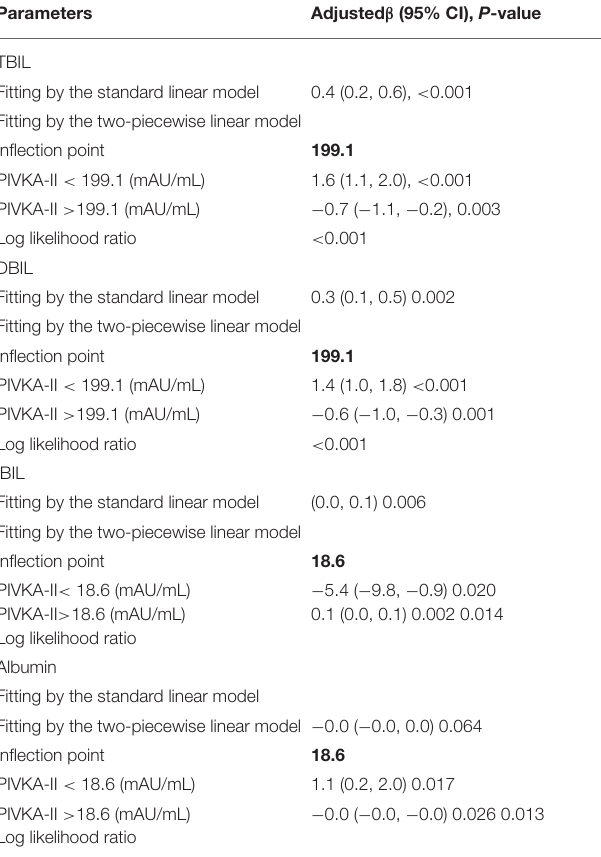
TABLE 4 | Threshold effect analysis of PIVKA-II on TBIL, DBIL, IBIL, and albumin using the two-piecewise linear regression model.